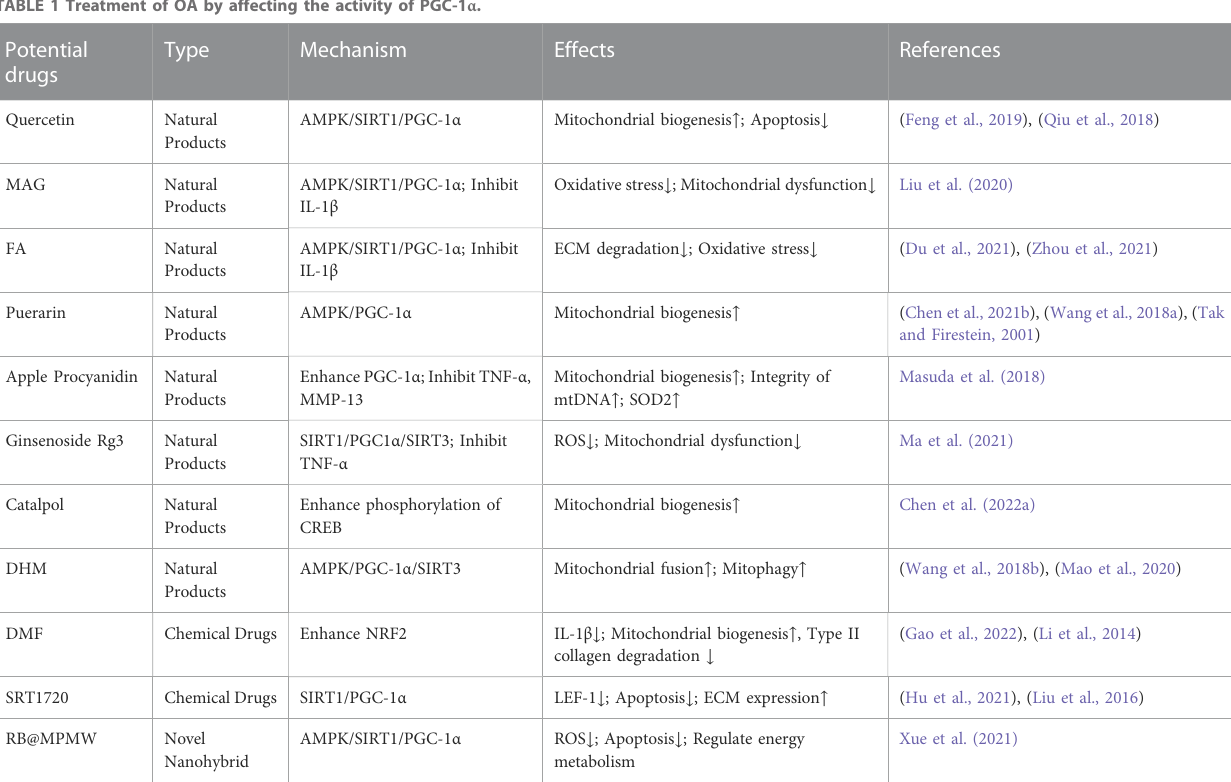
TABLE 1 Treatment of OA by affecting the activity of PGC-1 α